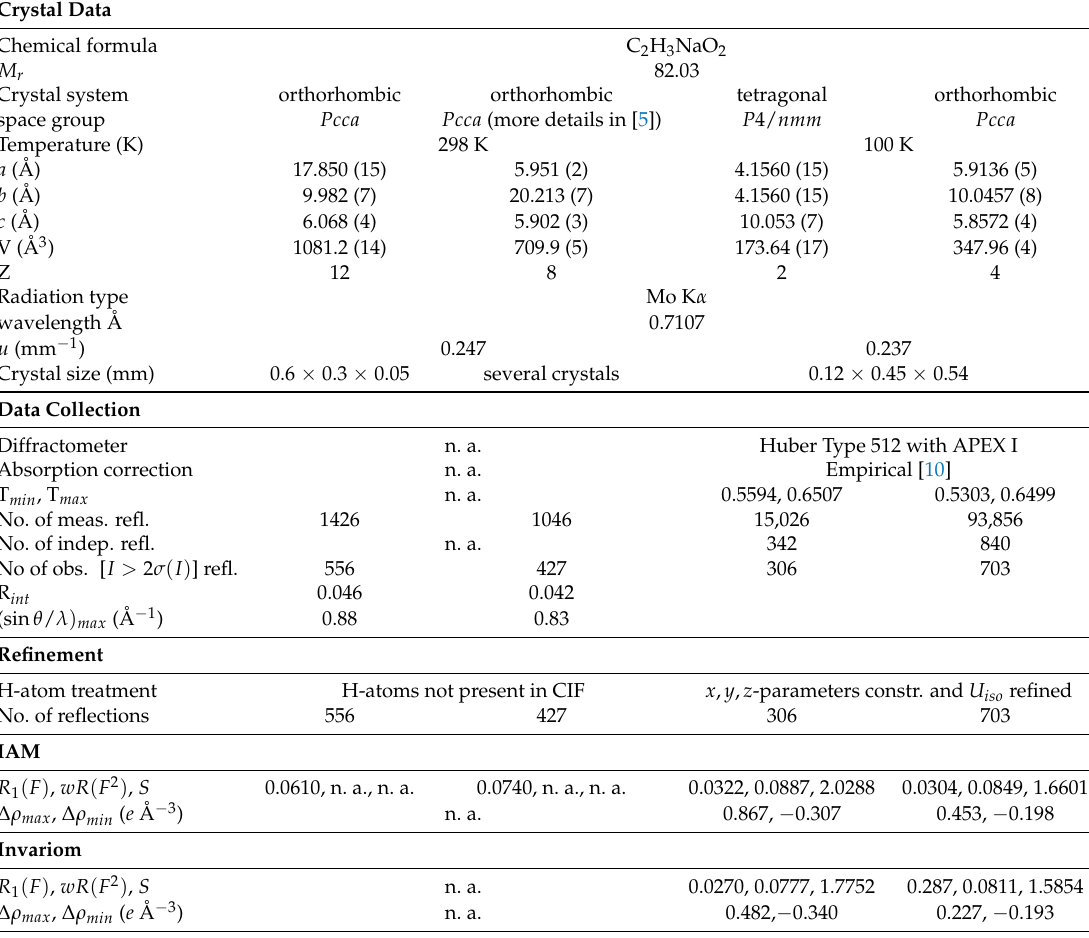
Table 1. Experimental, crystallographic and refinement